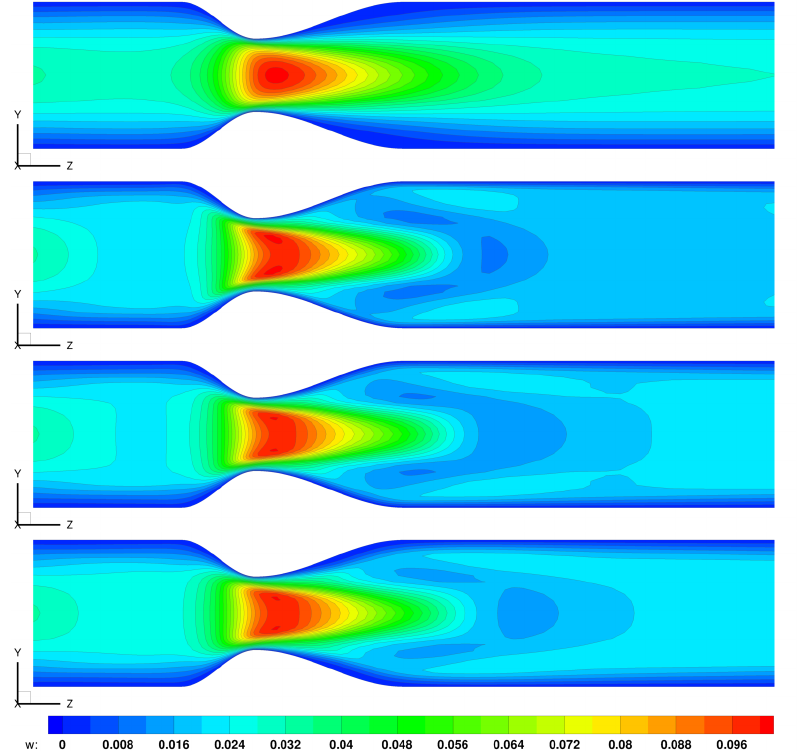
Figure 14. Axial velocity at flow rate Q = 0.5 cm 3 /s—GOB (top figure) and Johnson–Segalman models for a = − 0.9, a = − 0.8, a = − 0.7 (from the top).